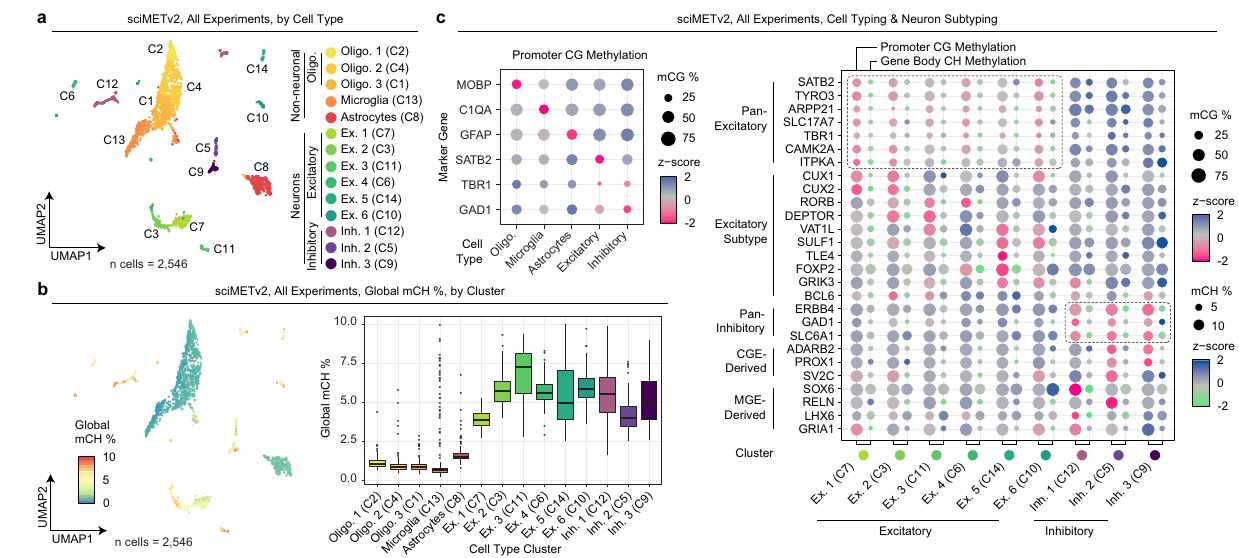
Fig. 4 | sciMETv2 cell type analysis and method bias assessment. a UMAP pro- jection of the three sciMETv2 preparations integrated together colored by cluster. b GlobalCHmethylationlevelspercellintheUMAPprojection(left)andbycluster (right).For all boxplots, boxes indicate median, 25th and 75th percentiles with min and max lines as 1.5x interquartile range. c Promoter CG methylation levels of